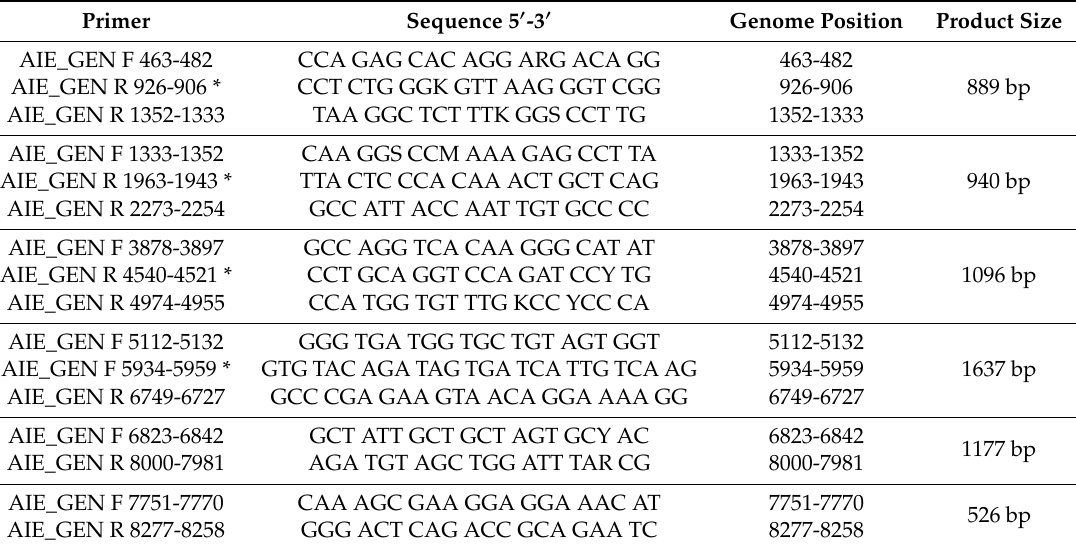
Table 1. Primers for equine infectious anemia virus (EIAV) genome regions. Genome positions are according to